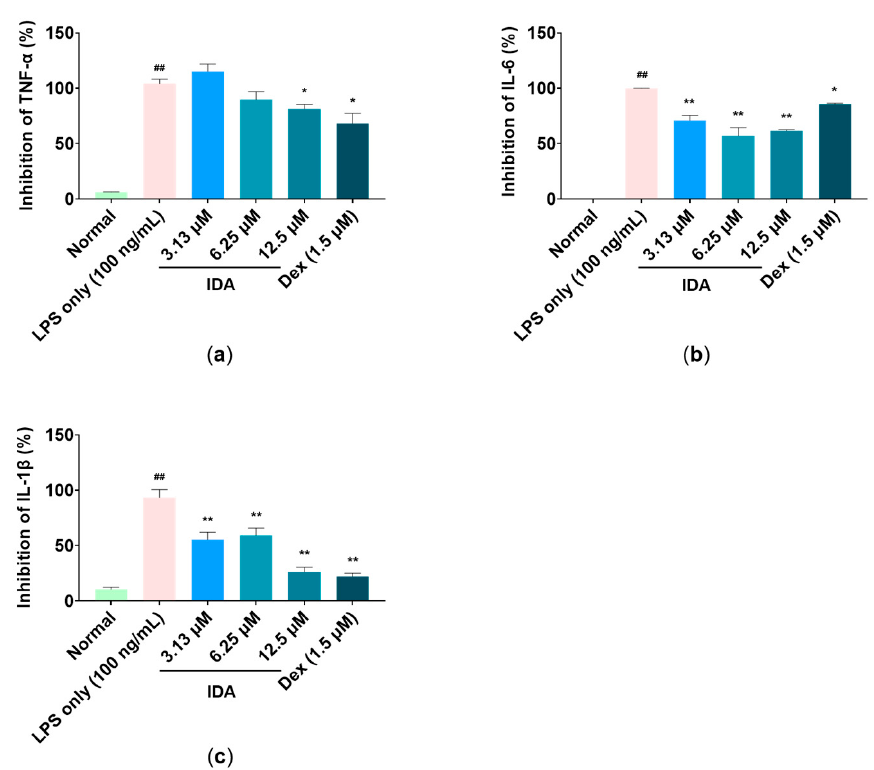
Figure 4. Effect of isodorsmanin A (IDA) on the expression levels of the proinflammatory cytokines: ( a ) tumor necrosis factor- α (TNF- α ), ( b ) interleukin-6 (IL-6), and ( c ) interleukin-1 β (IL-1 β ) in macrophages. Cells were pretreated with IDA (3.13, 6.25, or 12.5 µ M) for 3 h and then stimulated with 100 ng/mL of LPS for another 21 h. The experimental values are presented as the mean ± standard error of triplicate independent experiments. * p < 0.05 and ** p < 0.01 indicate significant differences vs. the LPS-only group. ## p < 0.01 indicates significant difference vs. Normal group. Dexamethasone (Dex); positive